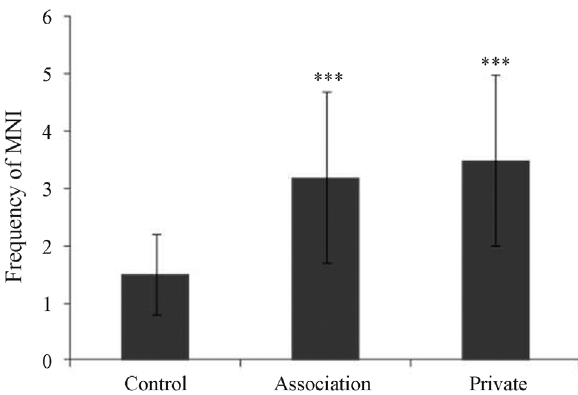
Figure1 -ComparisonoftheMNifrequenciesbetweengroupsofworkers exposed to pesticides and the control group (in 1,000 cells). ***p < 0.001 (Kruskal-Wallis